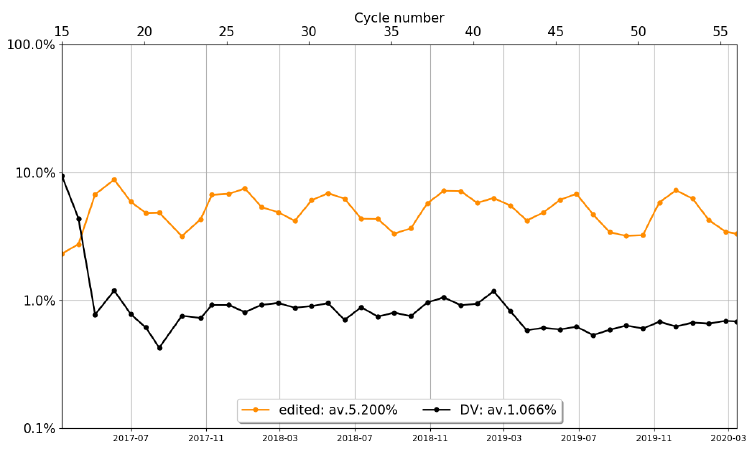
Figure 45. Percentage of default values and edited measurements over lakes for the OCOG backscatter coefficient for